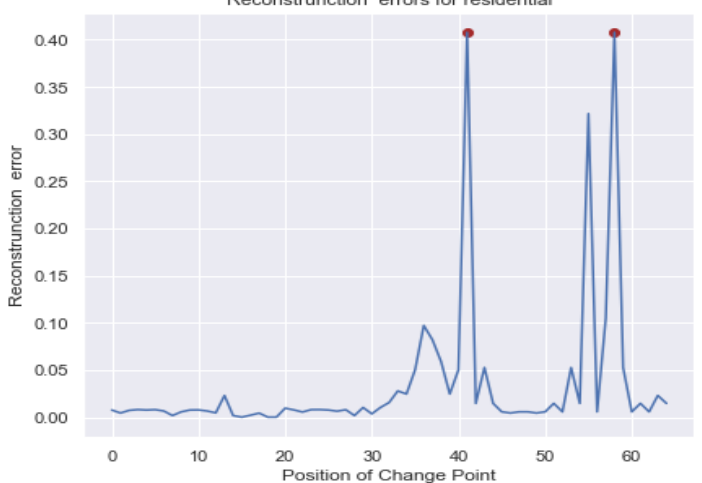
Figure 3. Reconstruction errors for residential.